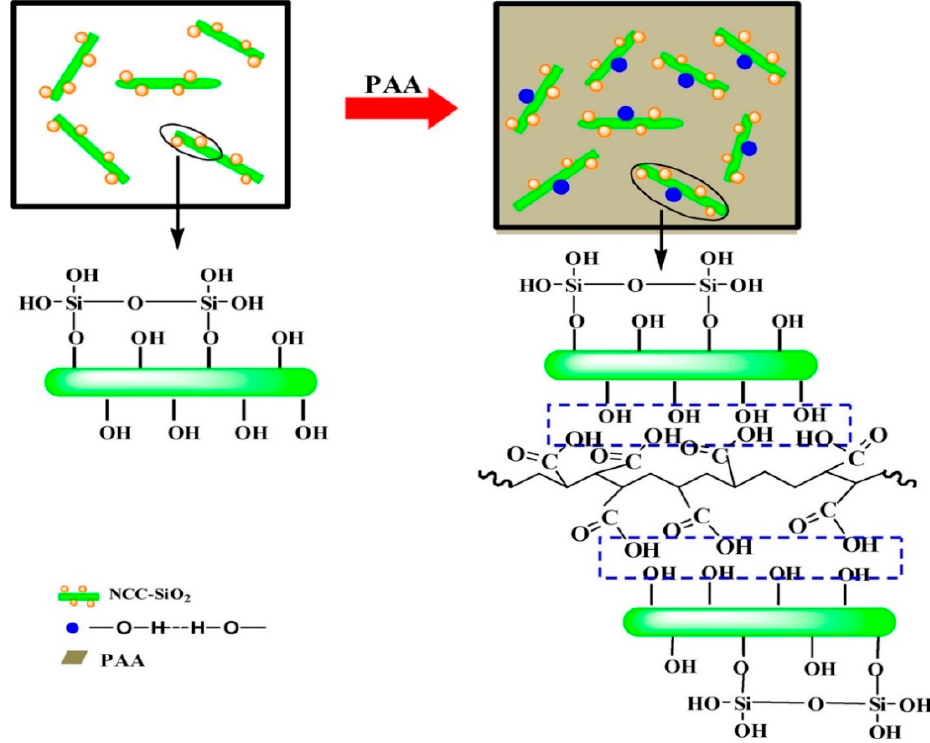
Figure 8. A proposed mechanism between the nanocellulose/SiO 2 hybrid fiber and PAA matrix [217].